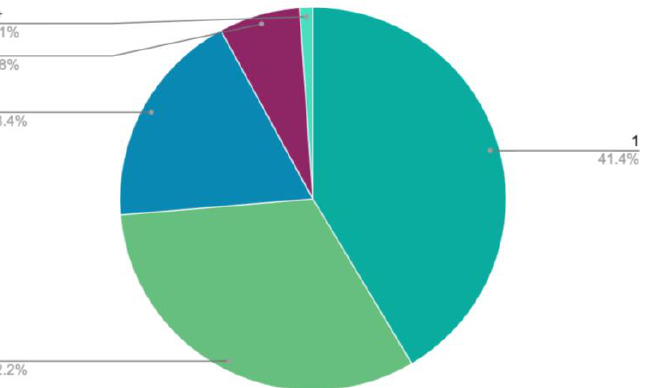
Figure 2. Proportion of patients with high-impact PGx medications by number of clinical areas impacted ( n = 30,471).